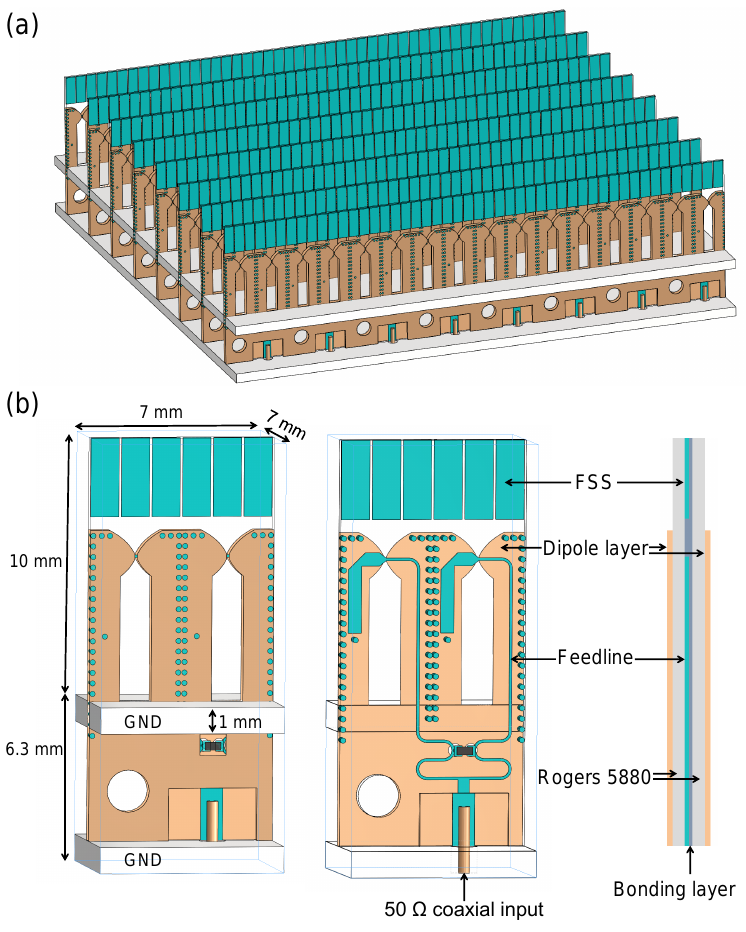
Figure 1. Topology of the proposed TCDA. ( a ) 8 × 8 array; ( b ) Unit cell: exterior view, interior view (with the front dipole layer removed), and side view.